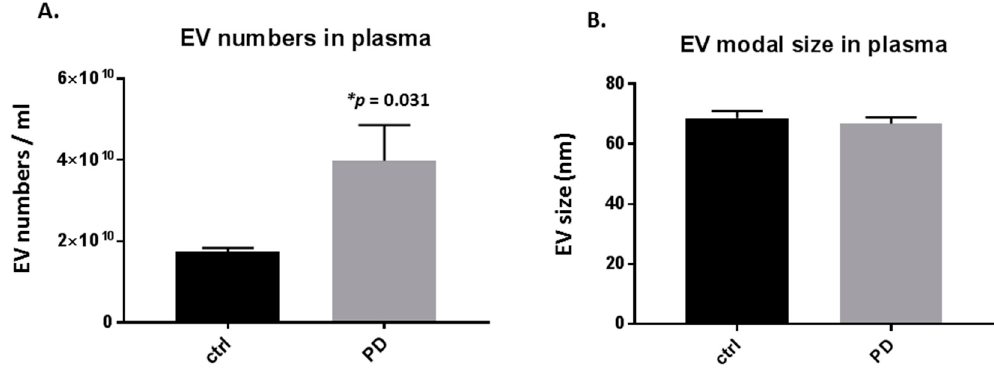
Figure 1. Plasma-extracellular vesicles (EVs) are elevated in pre-motor Parkinson’s disease (PD) model rats. ( A ) The number of circulating plasma-EVs was significantly increased in plasma of the pre-motor PD model rats, compared with that in plasma of sham control rats ( p < 0.05; unpaired t- test). ( B ) Modal size of plasma-EVs did not differ between plasma from the pre-motor PD rat model compared to control shams. Exact p -values are indicated ( n = 3 biological replicates for all; ctrl=sham; PD=pre-motor PD models).